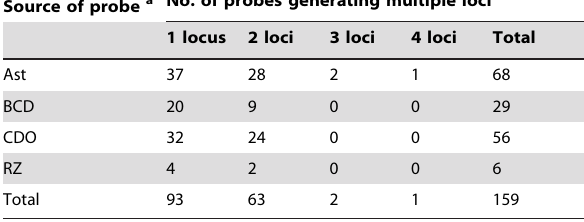
Table 1. Duplicate RFLP loci mapped in the 549 6 372 mapping population of creeping